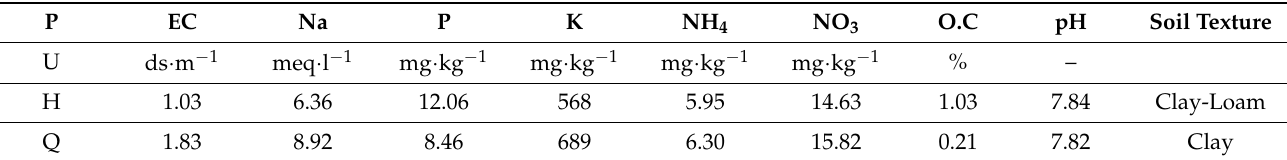
Table 1. Results of the experimental farm soil from a depth of 0–60 cm. P: Parameters of the soil; U: Units; H: Hamedan (location); Q: Qom